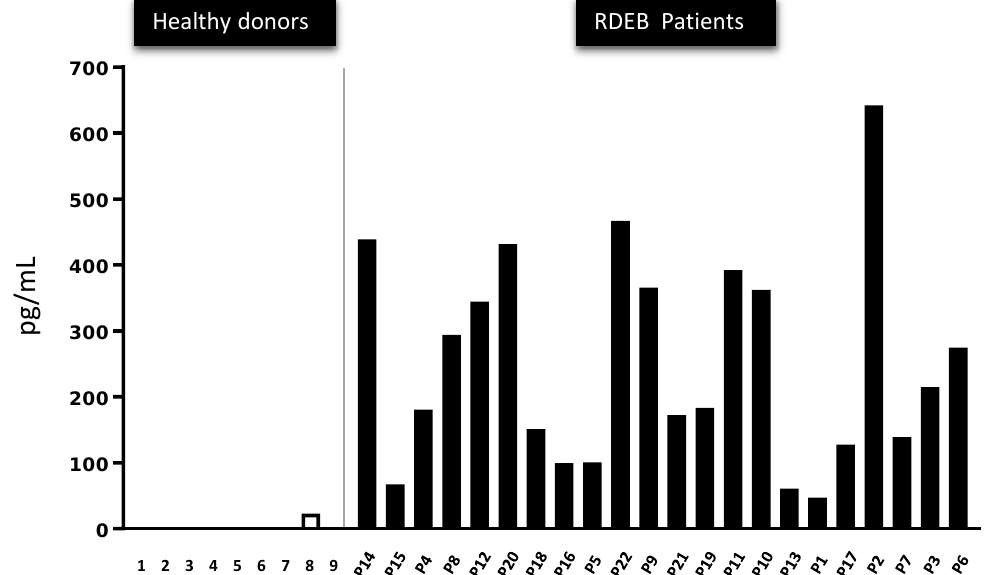
Figure 5. The active TGF- β 1 peptide in the serum of 22 RDEB patients relative to the healthy control individuals. ELISA measurement of the active TGF- β 1 peptide showing aberrant high levels of this peptide and its absence (detectable) in healthy individuals.